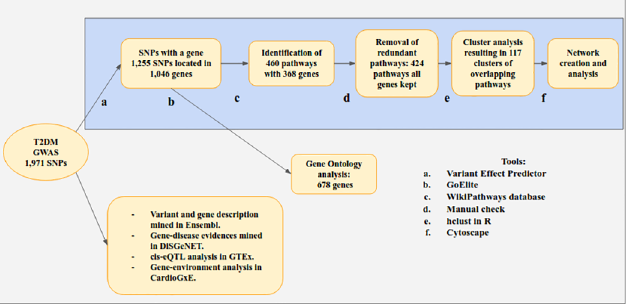
Fig 1. Workflow of GWAS data analysis. The data processing, online resources and tools used to perform the GWAS data analysis and visualization, as described in Materials and Methods.